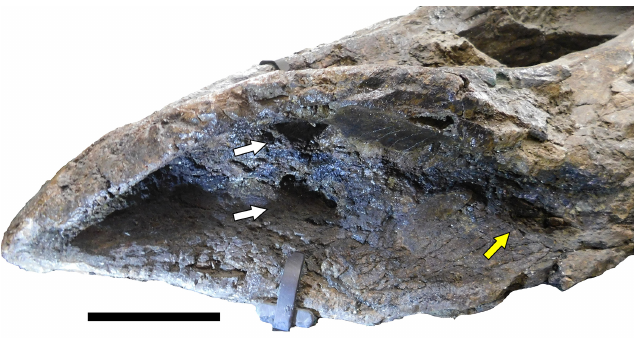
Figure 13. Ventral view of the premaxillae of MOR 981. White arrows indicate the enlarged primary foramina. Yellow arrow indicates the possible position of the second - ary foramen, well caudal to the primary foramina (Farke 2007). Scale, 10